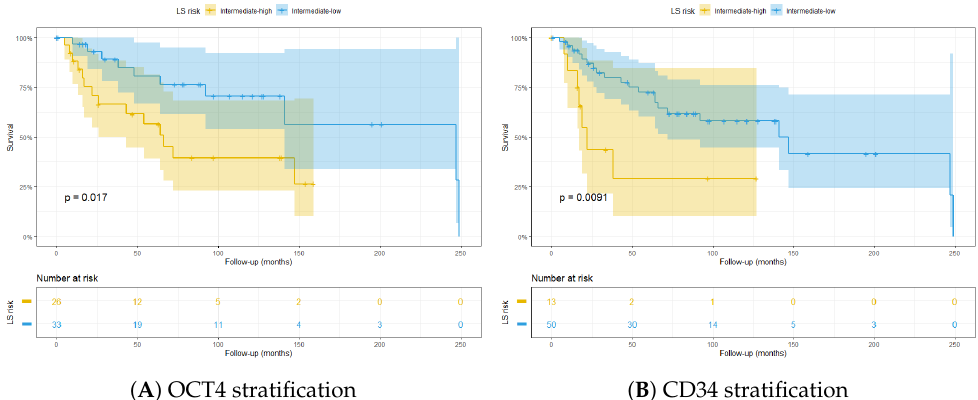
Figure 8. Stratification of patients at intermediate ISUP LS, based on: ( A ) OCT4 detected through multiplex IF; and ( B ) CD34 detected through DSP.